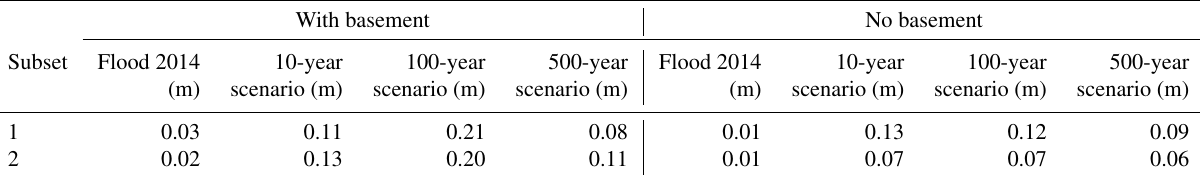
Table 5. Flood depths necessary for causing a DF equal to 0.1, according to the two building type subsets. With basement No basement